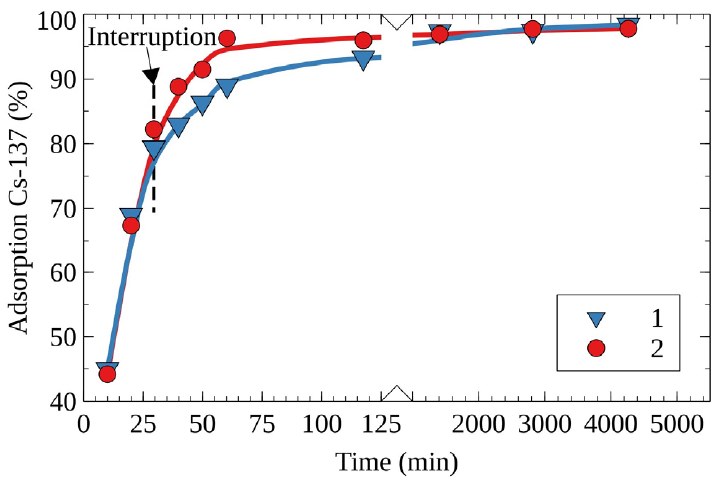
Figure 2. Kinetic curves of Cs-137’s removal from the solution No. 1 on the RFR-I resin, 1—the experiment without interruption (control), 2—the experiment with interruption.